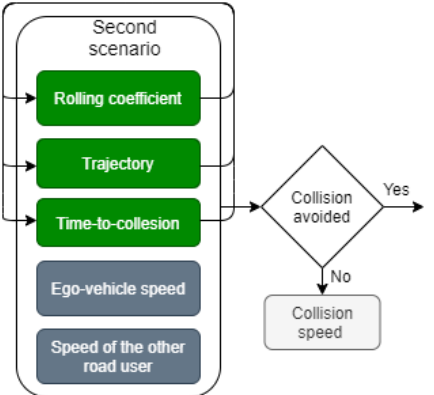
Figure 12. Parameters used in the sensitivity analysis in the second